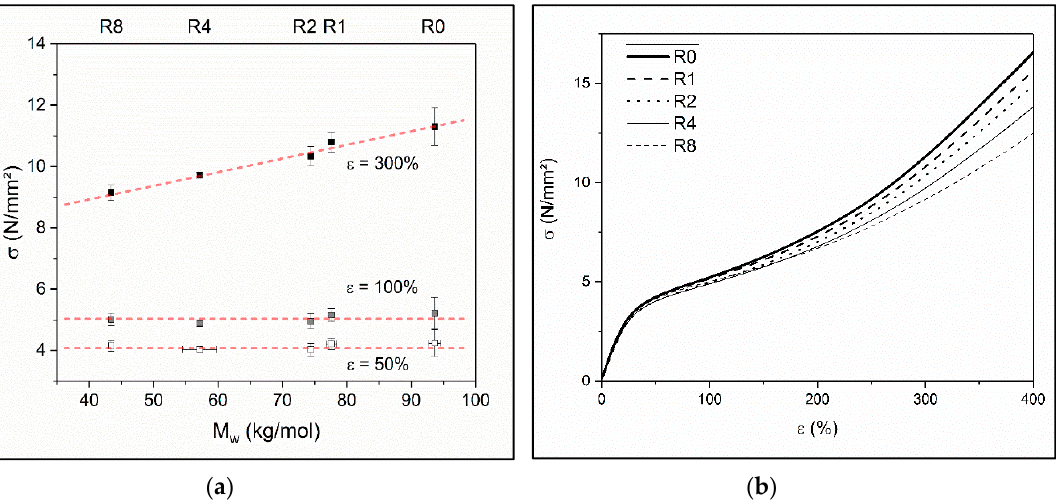
Figure 5. ( a ) Tensile stress of recycled TPU material for different elongations as a function of weight average molar mass M w . The top axis indicates the recycling step Rx (x = 0, 1, 2, 4, and 8); ( b ) Corresponding mean stress–strain–curves of the measured values from recycling step Rx (x = 0, 1, 2, 4, and 8) shown in ( a ).